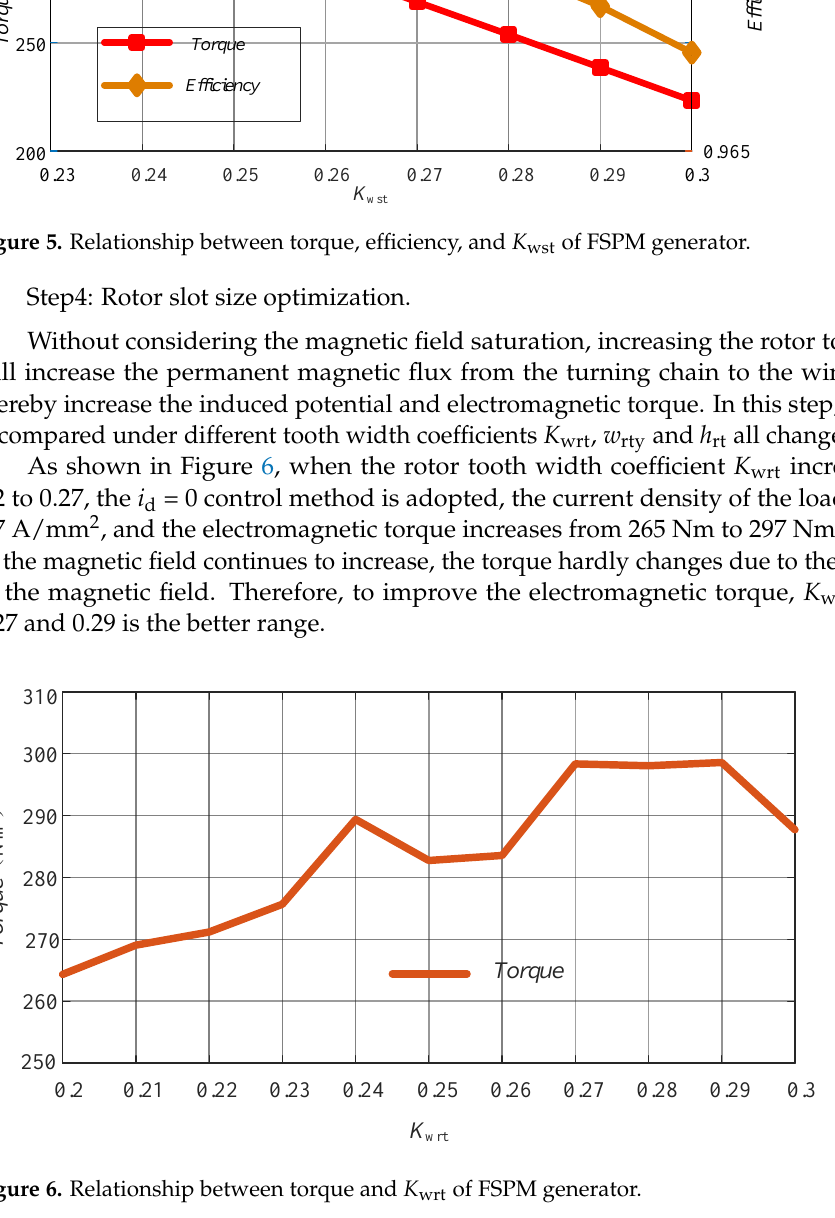
Figure 4. This is a figure. Schemes follow the same formatting.